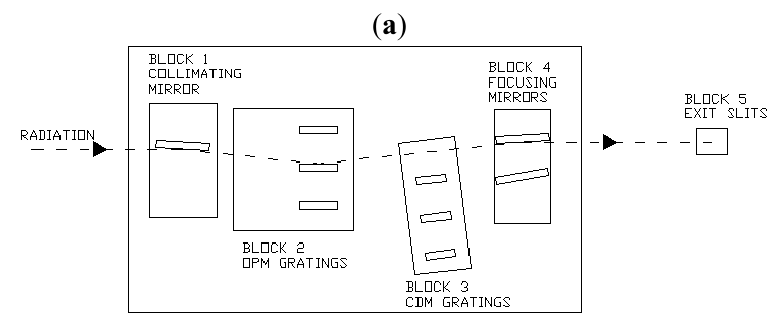
Figure 6. Block diagram of the double-stage monochromator: ( a ) OPM configuration; ( b ) CDM